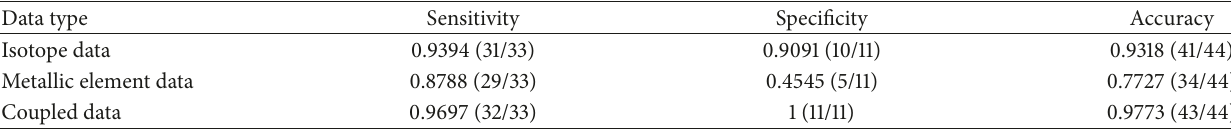
Table 6: Predicting results obtained by SVM.